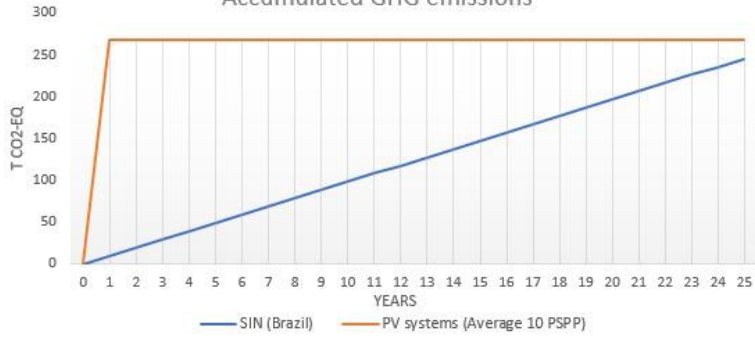
Figure 9. Comparison of system GHG emissions